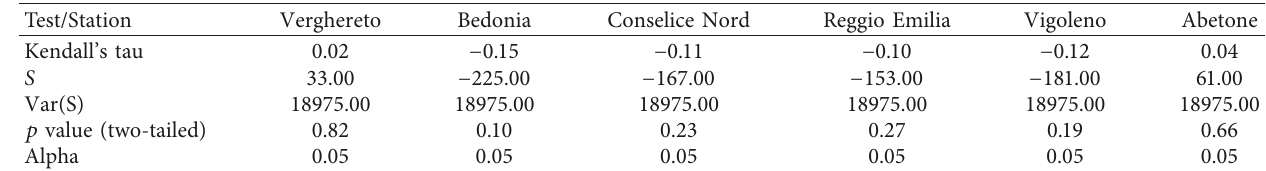
Figure 9: Temporal variation and trend line of annual PP for six meteorological stations during the period 1961–2015. (a) Verghereto, (b) Reggio Emilia, (c) Bedonia, (d) Vigoleno, (e) Conselice, and (f) Abetone. For the locations of the weather stations, refer to Figure 1. Table 4: The Mann-Kendall trend test statistic applied for annual precipitation observations.